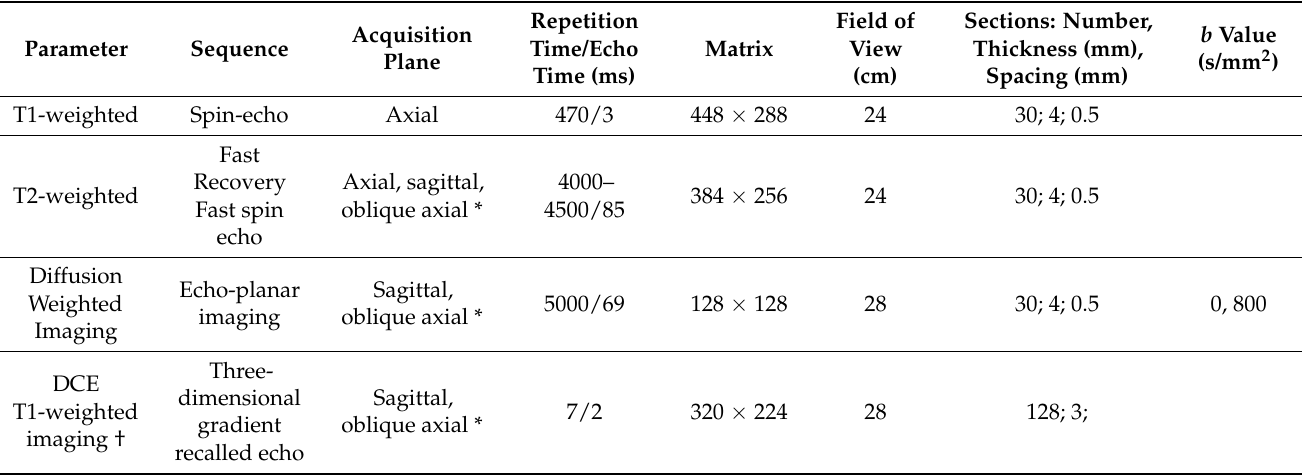
Table 1. Acquisition parameters of the MRI sequences employed to observe endometrial